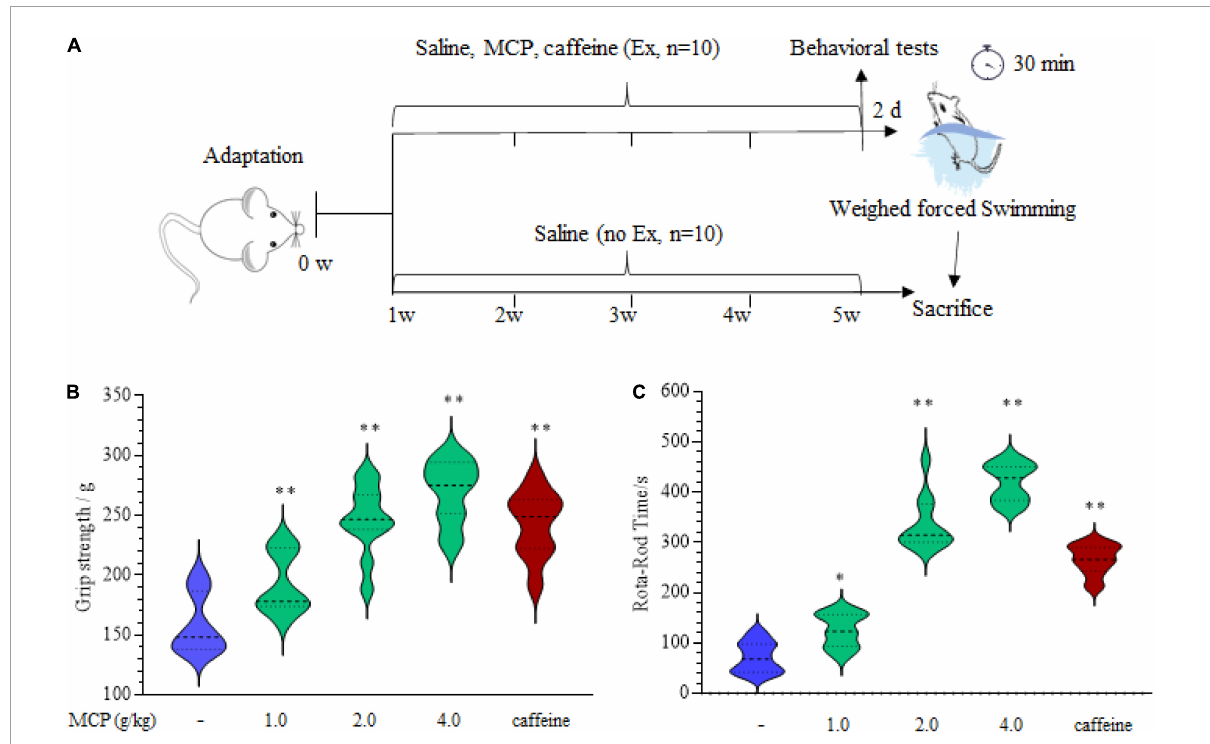
FIGURE1 Effects of Maca compound preparation (MCP) on the mice physical fitness measurement tests. (A) Scheme of animal experiments of the weighed-forced swimming test (WFST, 5% bodyweight). (B) The forelimb grip strength of mice examined by grip-strength test. (C) The motor coordination of mice in Rota-rod test. ∗ p < 0.05, ∗∗ p < 0.01 vs. control group